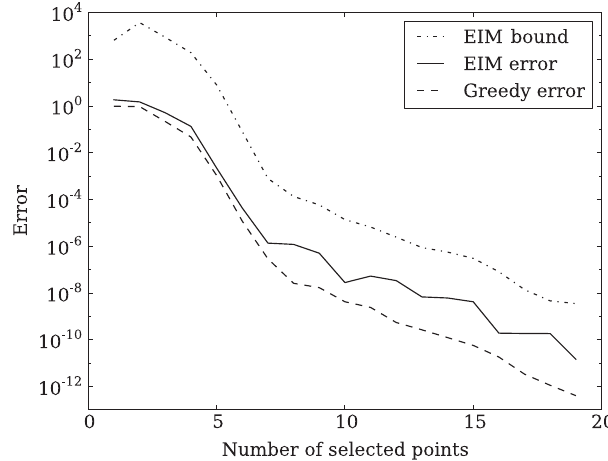
FIG. 6. A comparison of errors for the example family of EOB waveforms. The dashed line shows the greedy error σ m in Eq. (9). The solid line shows the maximum empirical interpolant error (21) taken over 1,000 randomly selected waveforms (i.e., not taken from the training set) for q ∈ ½ 1 ; 2 (cid:1) . The dash-dotted line shows the error bound provided by the right side of Eq. (20) and is based solely on the greedy error and Λ m . All three errors display similar decay